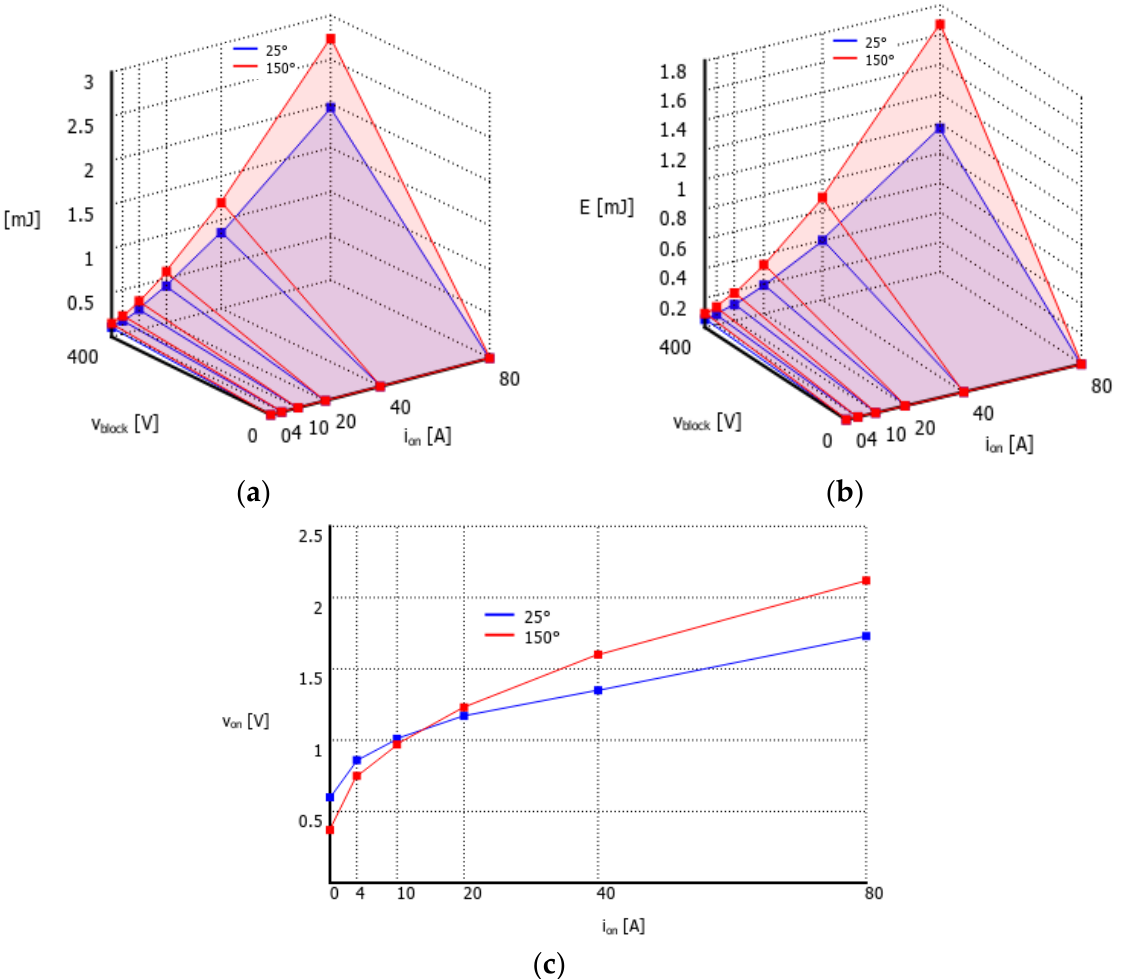
Figure 11. IGBT thermal description corresponding to ( a ) Turn ON losses, ( b ) Turn OFF losses, and ( c ) conduction losses.